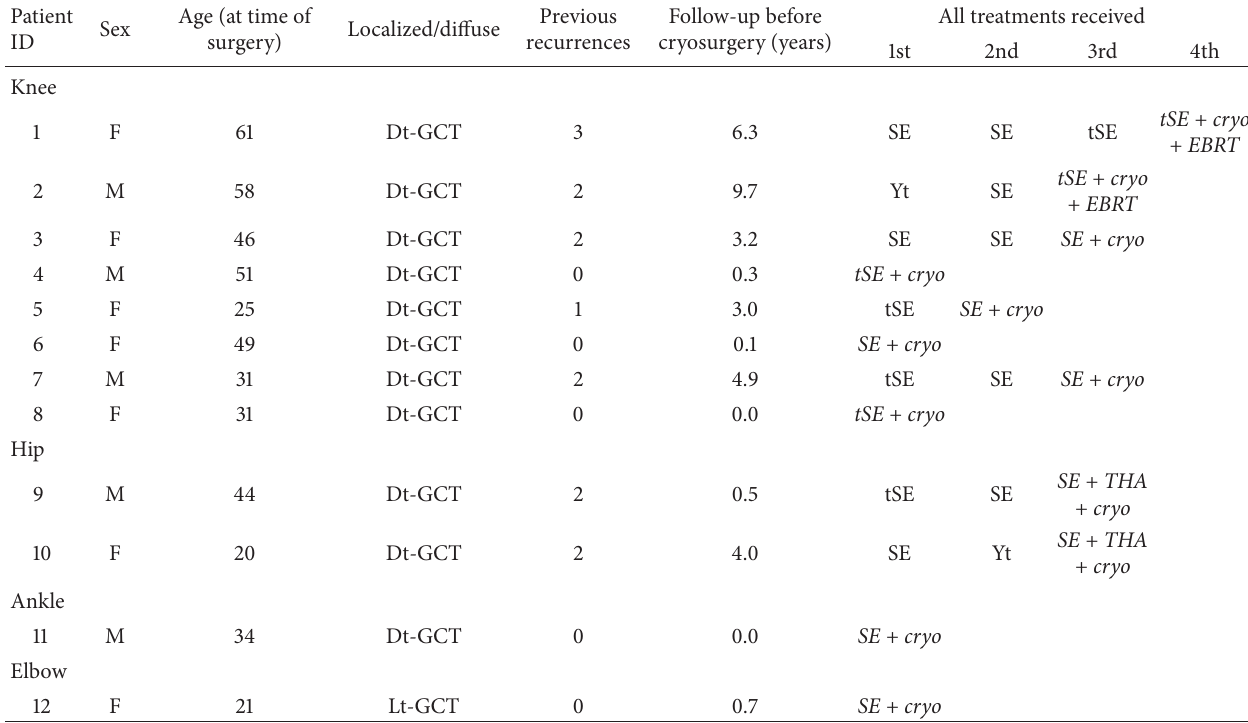
F: female, M: male, SE: surgical synovectomy, tSE: two-stage synovectomy (anterior and posterior compartment of the knee in two separate procedures), Yt: yttrium radiosynovectomy, EBRT: external beam radiation therapy, cryo: cryosurgery, follow-up before cryosurgery: the time from diagnose until the use of cryosurgery in years, and THA: total hip